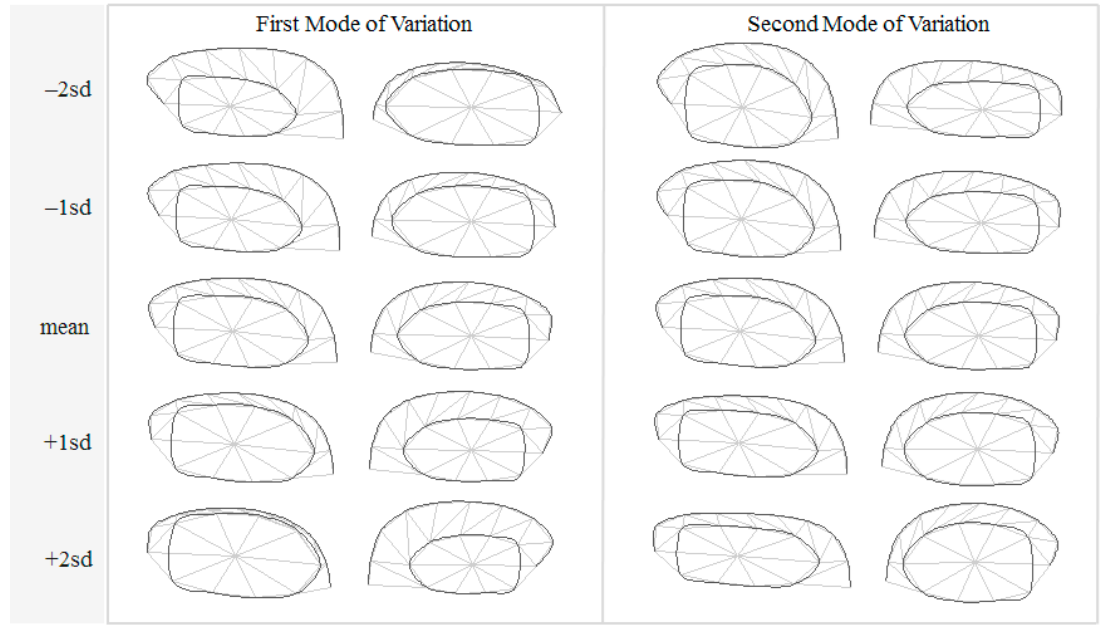
Figure 4. Principal modes of variations within ± 2 standard deviations.